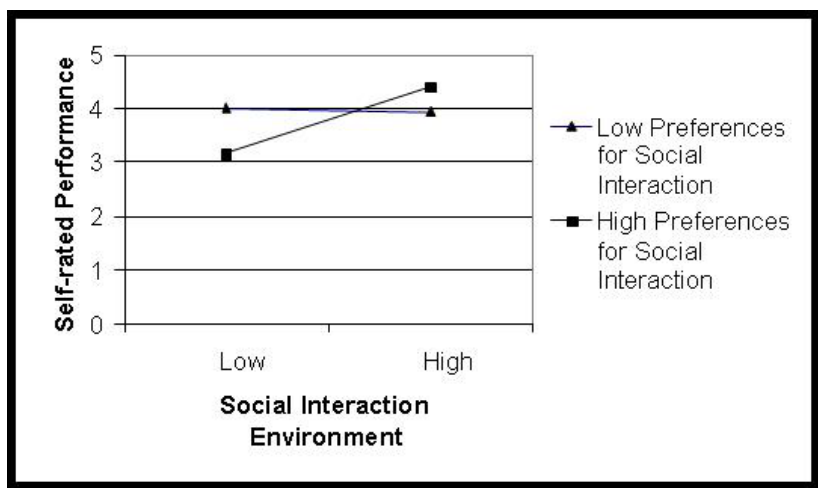
Figure 5. The interactive effect of preferences for social interaction and the social interaction environment on self-rated